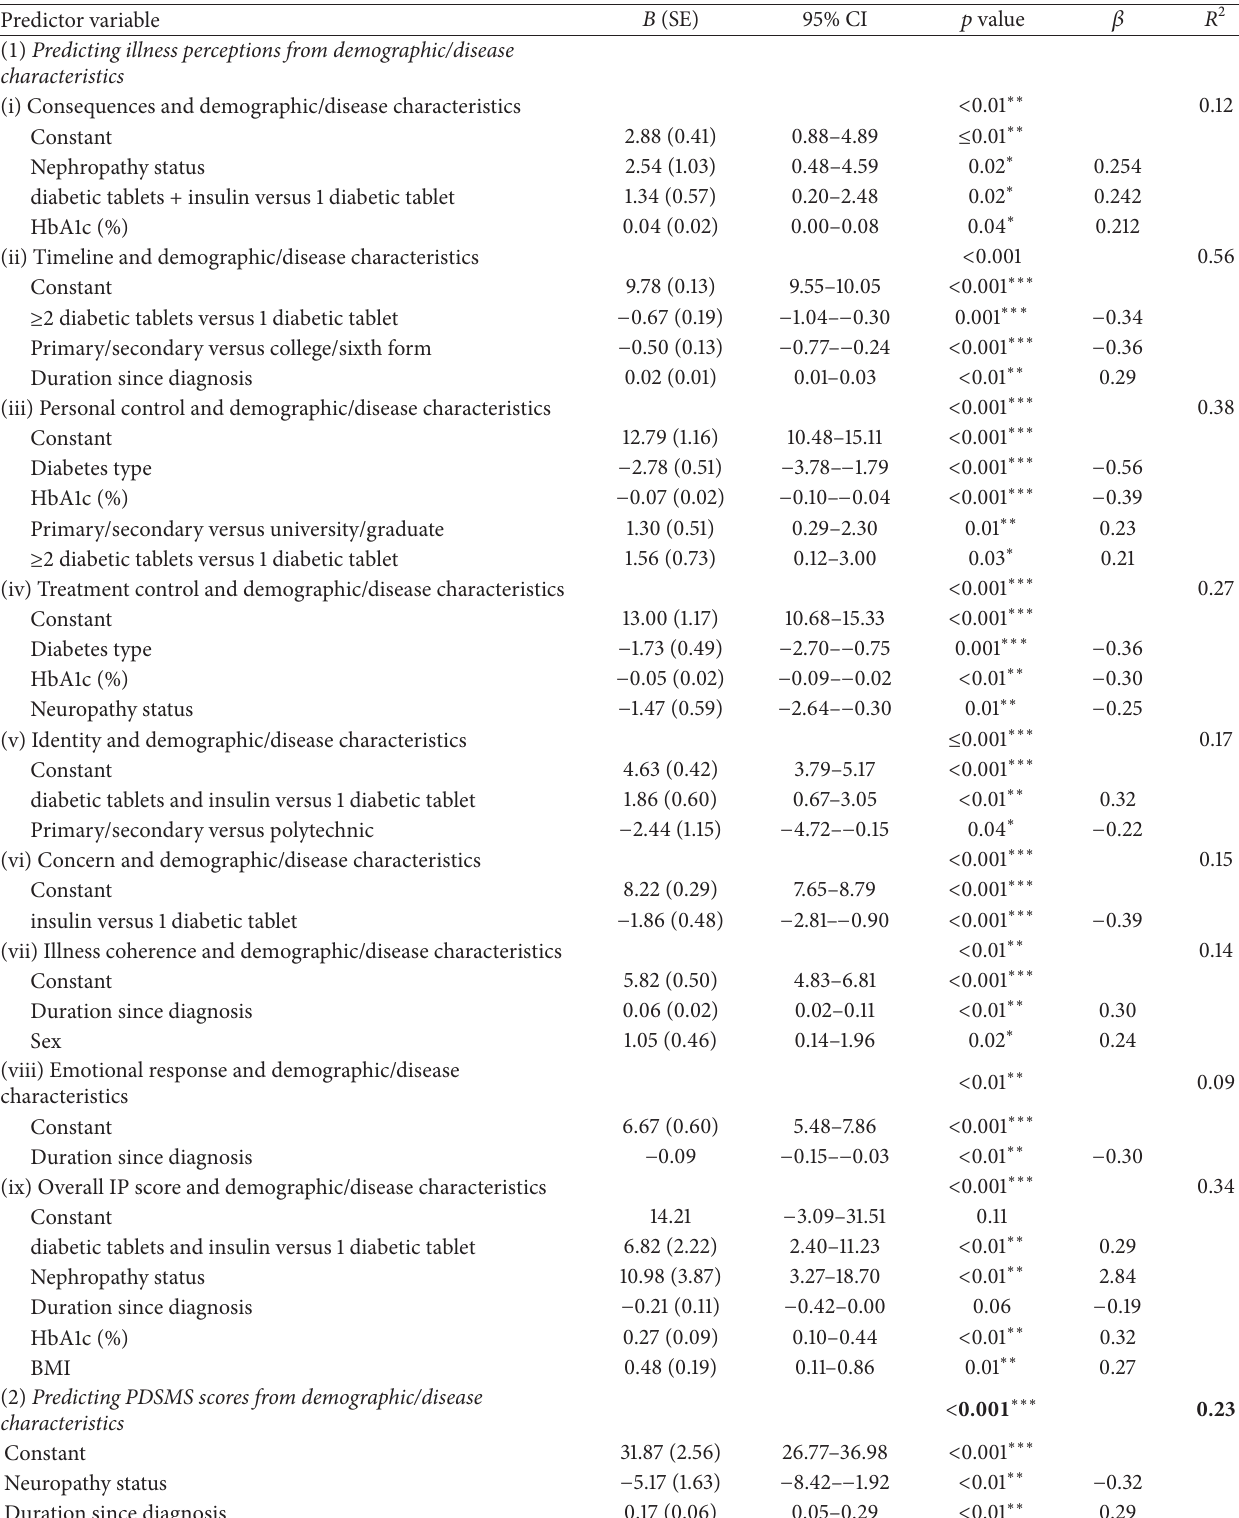
Table 2: Predicting illness perceptions, self-efficacy, and adherence to self-management recommendations from sociodemographic and disease